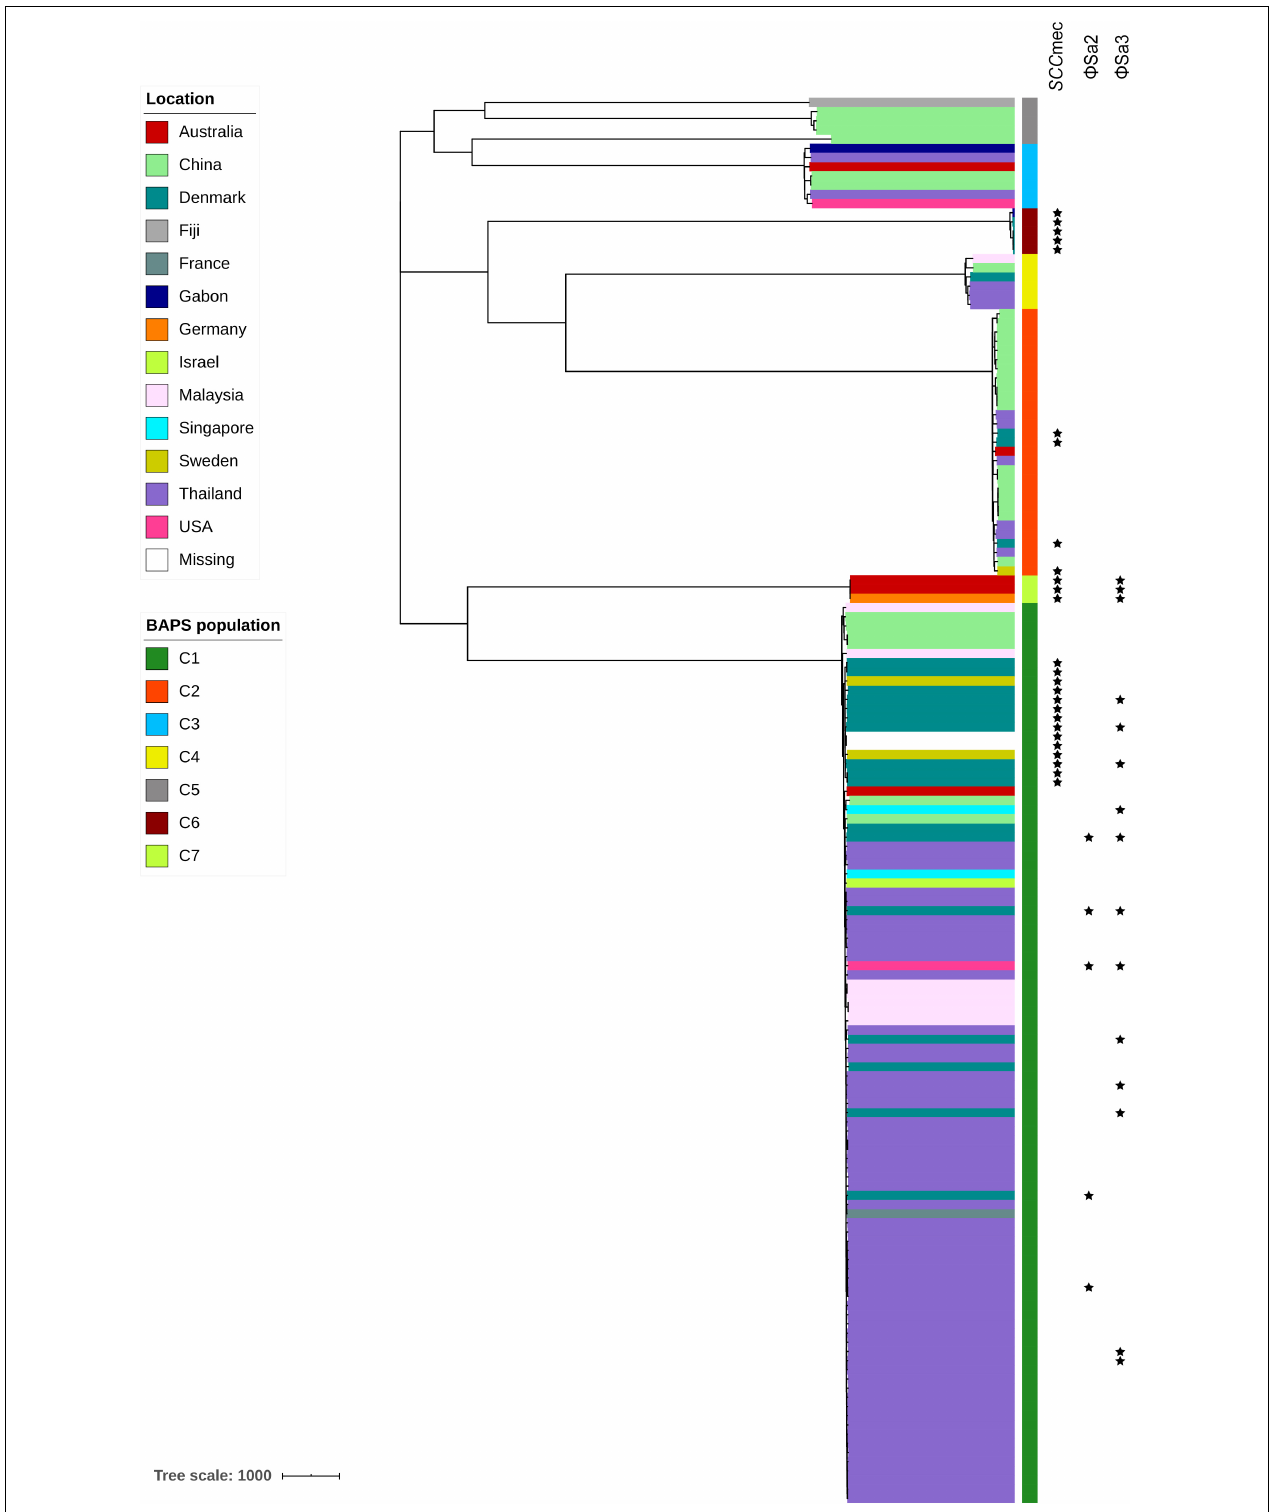
FIGURE 6 | The presence of staphylococcal cassette chromosome mec (SCC mec ) elements and prophages (cid:56) Sa2 and (cid:56) Sa3 among 153 S . argenteus strains. The clade colors indicate the source of each strain. The bar color indicates the BAPS cluster to which each strain is attributed. The star indicates the presence of the corresponding